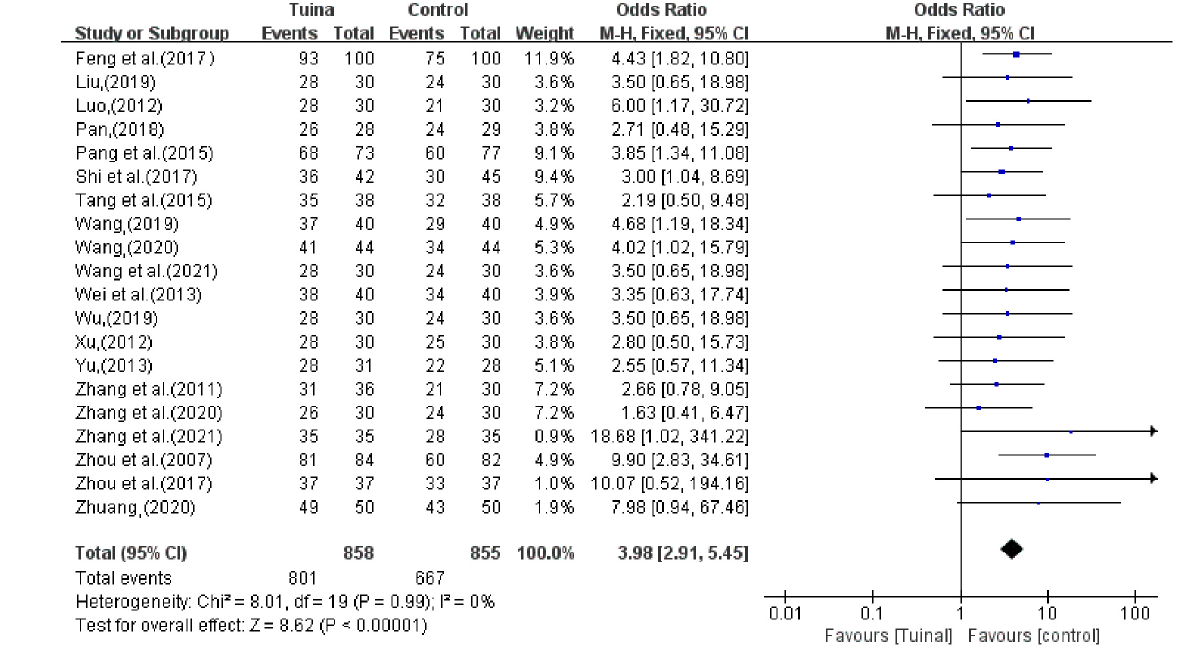
FIGURE4 Meta-analysis of objective response rate (ORR).